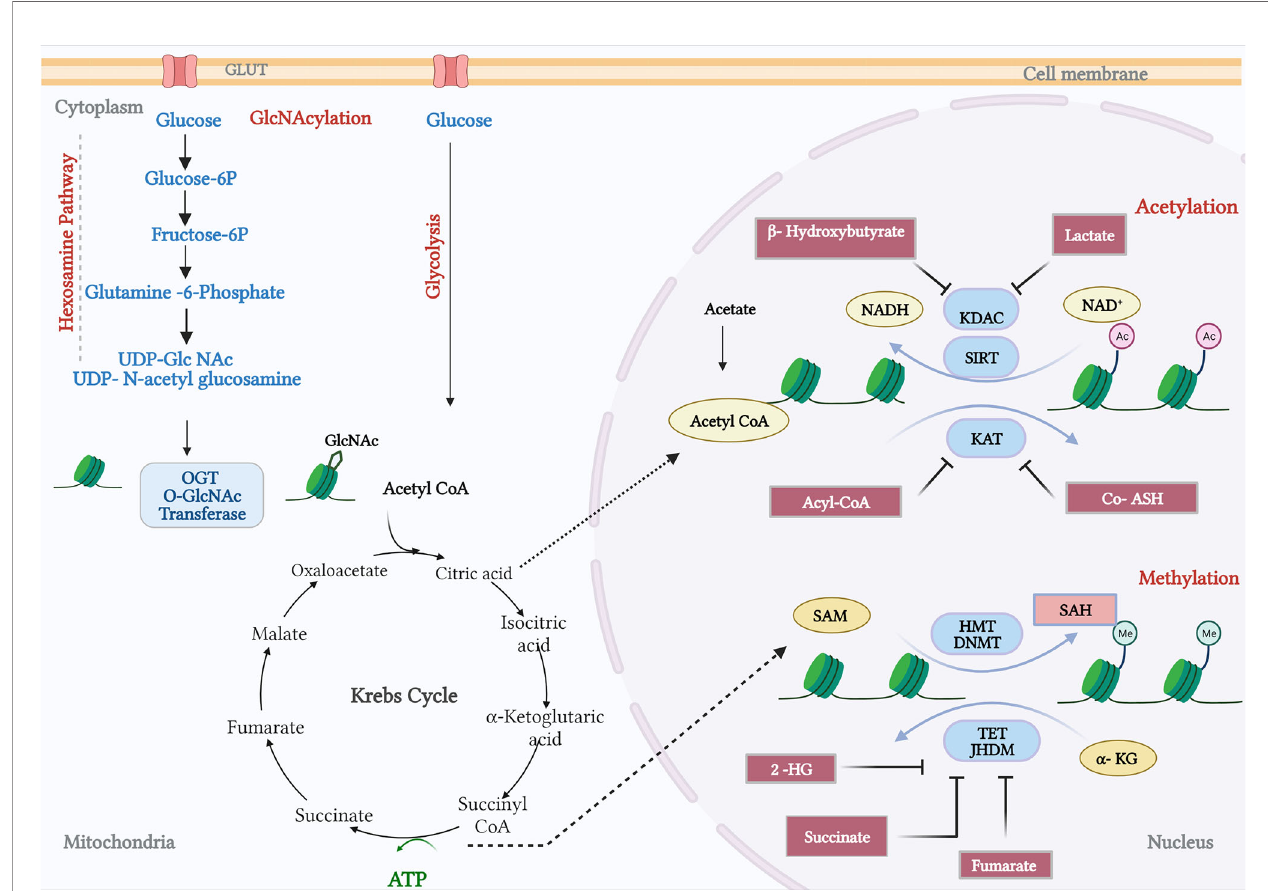
FIGURE 3 | Crosstalk between metabolism and prostate cancer genomics. The hexosamine pathway catalyses the conversion of glucose and glutamine to provide a metabolite UDP-glucosamine (UDP-GlcNAc). The O-GlcNAc transferase (OGT) facilitates the N-acetylglucosamination (GlcNAcylation) or Glycation process. In addition, the Krebs cycle fuels metabolites private and citrate, which gets converted by acyl-COA synthetase and pyruvate dehydrogenase. Products from fatty acid oxidation, fatty Acyl CoA, inhibit the activity of lysine acetyltransferases (KAT). KAT reactions also release CoA-SH, which acts as an inhibitor. B-Hydroxybutyrate, a ketone from FA, and lactate, a by-product of glycolysis, have been shown to inhibit lysine deacetylase (KDAC). Amino acid metabolism and TCA cycle fuels in methionine and ATP, respectively, and synthesizes S-adenosylmethionine (SAM). Histone methyl transferases and DNA methyl transferases catalyse SAM to S-adenosylhomocysteine (SAH), which in turn can inhibit DNMTs and HMTs. TCA cycle intermediates, succinate, fumarate, a -ketoglutarate ( a -KG), and 2-hydroxyglutarate (2-HG) acts as inhibitors of TET demethylases and Jumonji-C (JMJC) domain-containing histone demethylases (JHDMs). The fi gure has been adapted and modi fi ed from the review